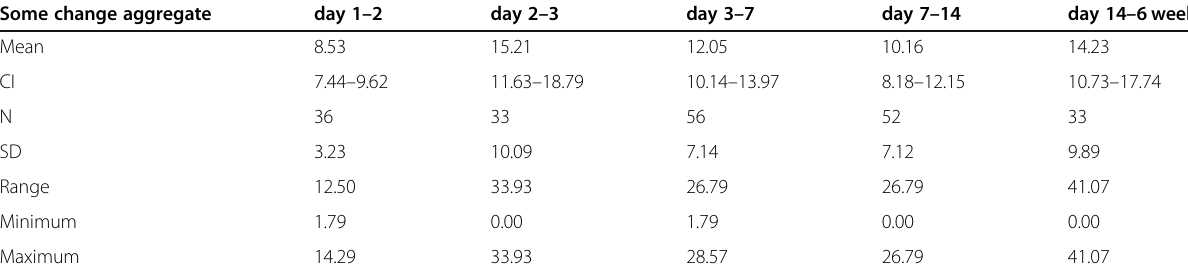
Table 13 Mean overall ‘ some change ’ aggregate OARS scores Some change aggregate